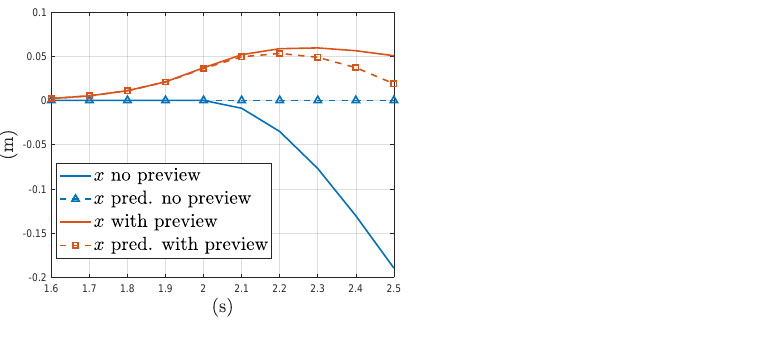
Figure 6. MPC forward position prediction vs actual response with a step input in forward wind of 10 ms − 1 at time t = 2 s.